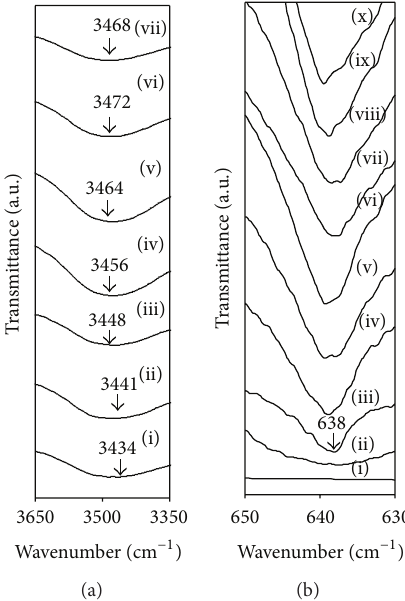
Figure 4: (a) FTIR spectra for 90wt.% PEO-10wt.% GO film with (i) 10 wt.% LiCF 3 SO 3 , (ii) 15 wt.% LiCF 3 SO 3 , (iii) 20 wt.% LiCF 3 SO 3 , (iv)